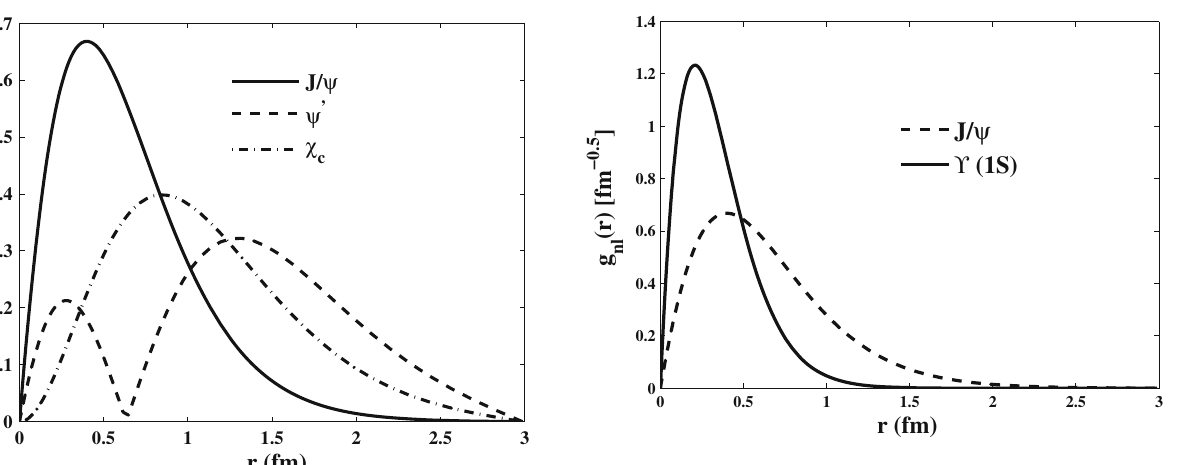
Fig. 5 Comparison of radial part of wavefunction of ϒ( 1 S ) and J /ψ at critical temperature T C = 160 MeV